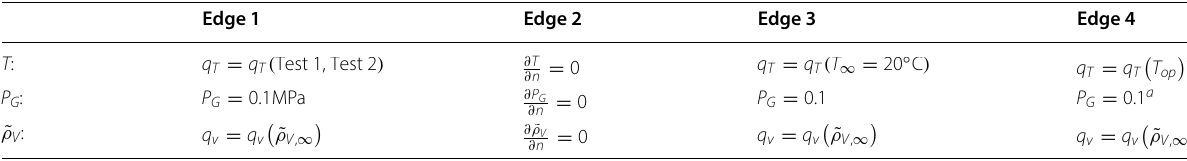
a Boundary conditions for case S1.